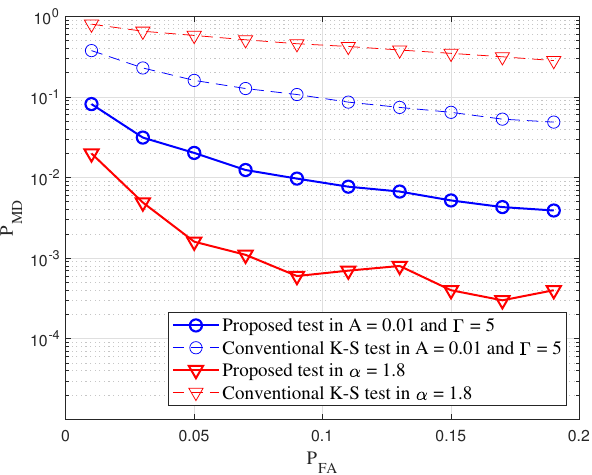
Figure 6. Comparison of P MD of the proposed test and the conventional K–S test in various impulsive noise environment. The parameter of Middleton class A noise is A = 10 − 2 and Γ = 5. Those of S α S noise equals to α = 1.8, δ = 0, and λ = 1/4. N equals to